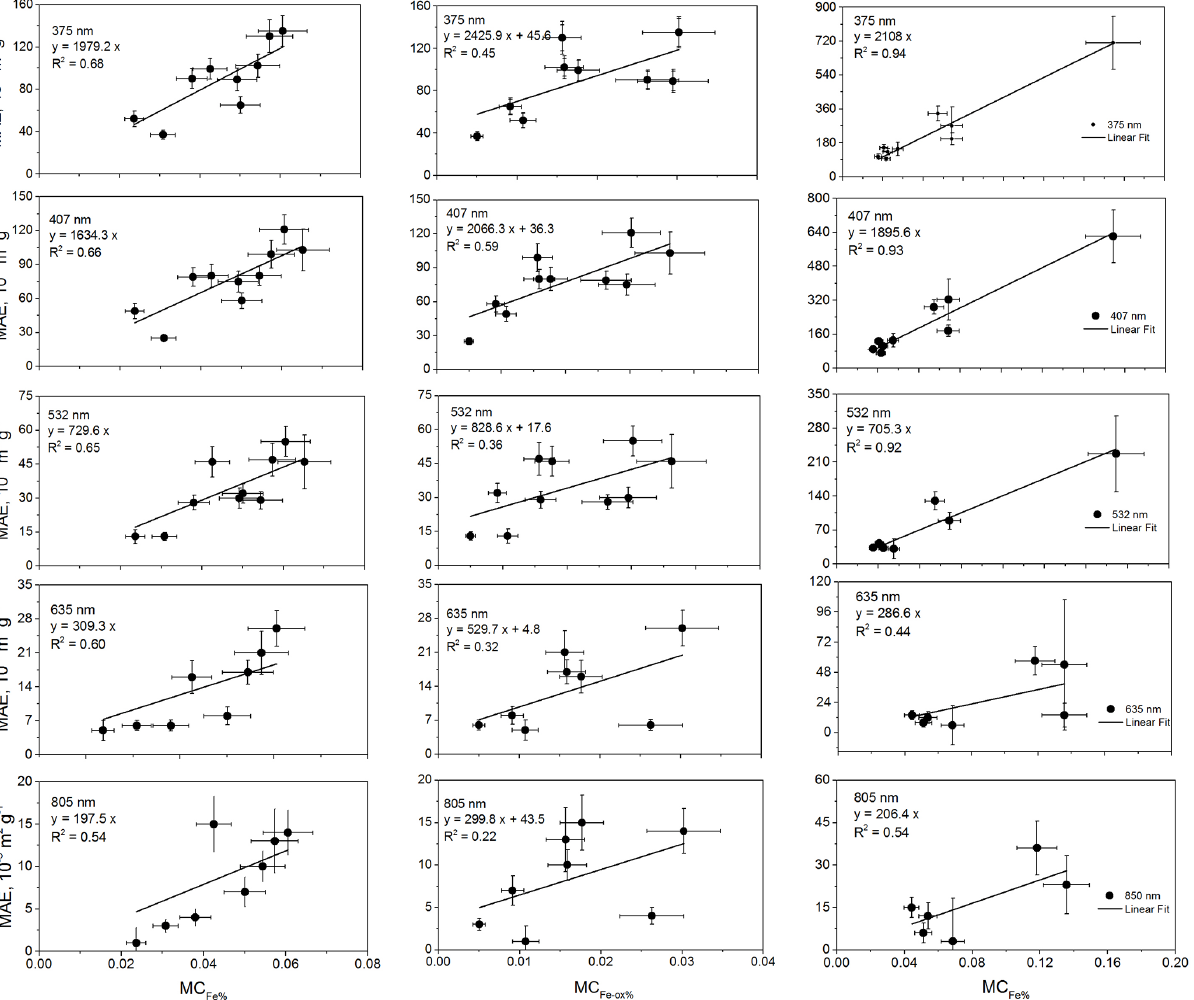
Figure 4. Illustration of the links between the MAE values and the dust chemical composition found in this study. Left column panels, from top to bottom: linear regression between the MAE values in the range from 375 to 850nm and the fraction of elemental iron relative to the total dust mass (MR Fe% ) in the PM 10 . 6 fraction; middle column panels: same as left column panels but for the mass fraction of iron oxides relative to the total dust mass (MR Fe ox% ) in the PM 10 . 6 size fraction; right column panels: same as left column panels but in the PM 2 . 5 size